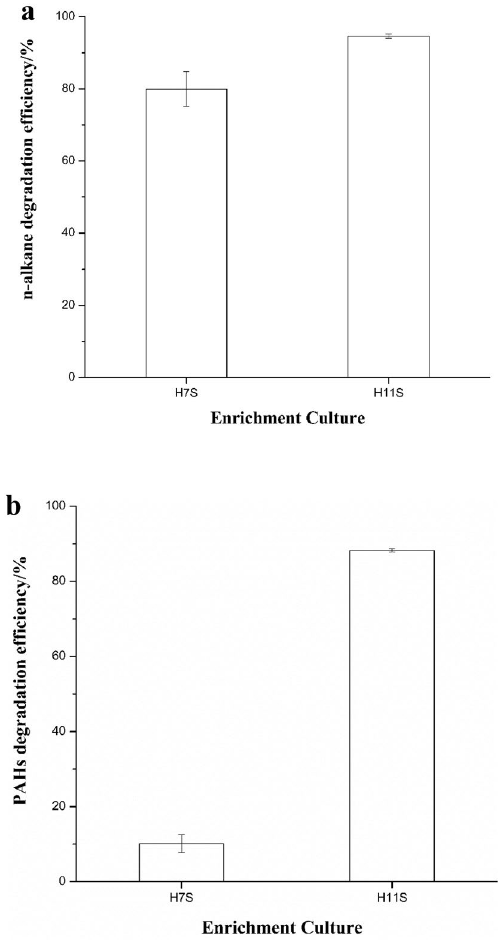
Figure 2. The total n -alkane and PAHs degradation efficiency of two enrichment cultures H7S and H11S ( a ) n -alkane degradation efficiency, ( b ) PAHs degradation